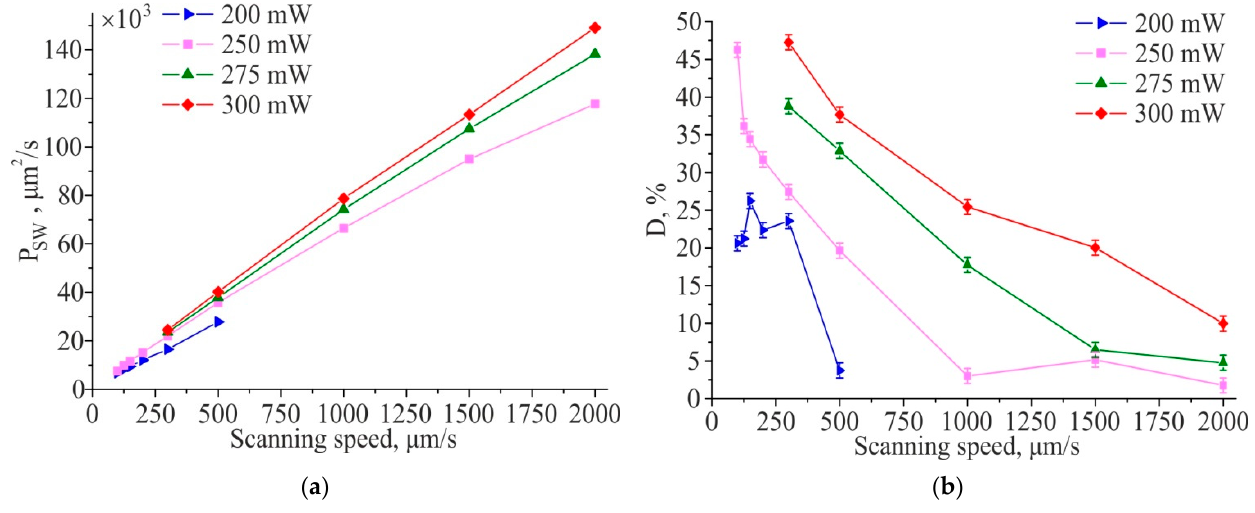
Figure 4. Productivity of TLIPSS formation on a hafnium film in air ( a ) and relative area of defects ( b ) at different scanning speeds and laser powers.